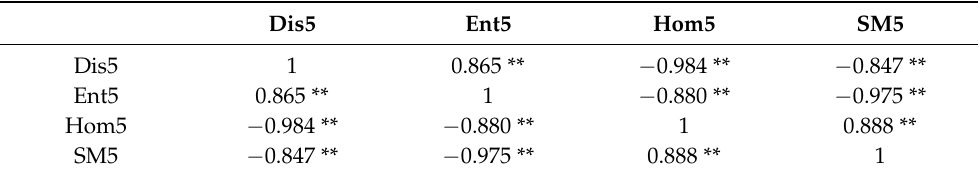
Table 10. Correlation coefficient matrix of texture features in red edge band 2.